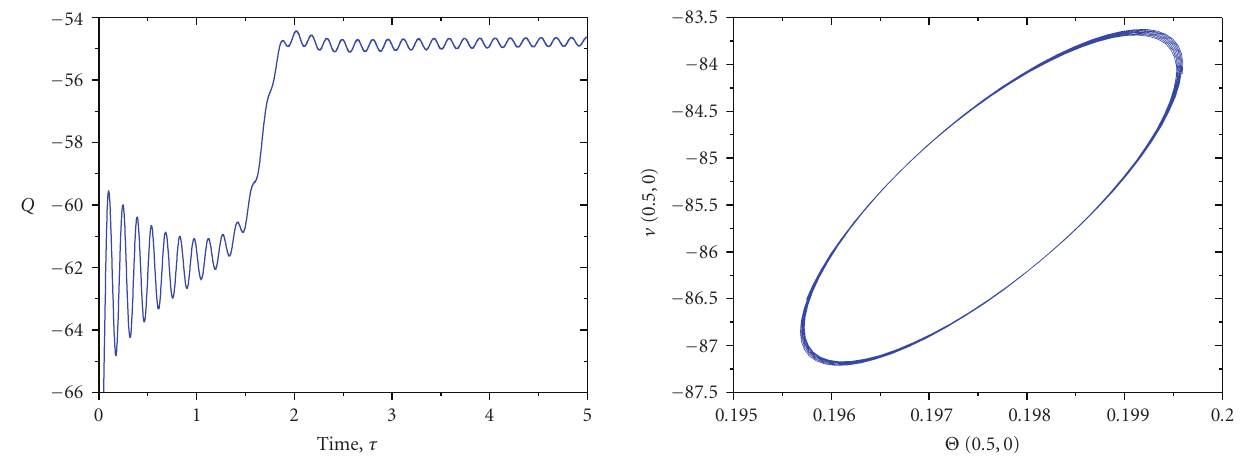
Figure 8: Oscillatory regime.